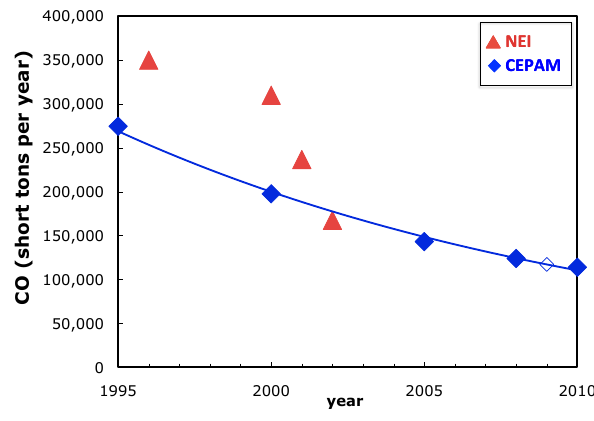
Fig. 4. Inventory-based estimates of CO emissions for Sacramento County, California. Red points are from USEPA NEI county level database (http://www.epa.gov/ttn/chief/eiinformation.html). Solid blue points are from the California Air Resources Board CEPAM database (http://www.arb.ca.gov/ei/ei.htm). The open blue point is interpolated for 2009 from the fitted curve (blue line) to the CEPAM